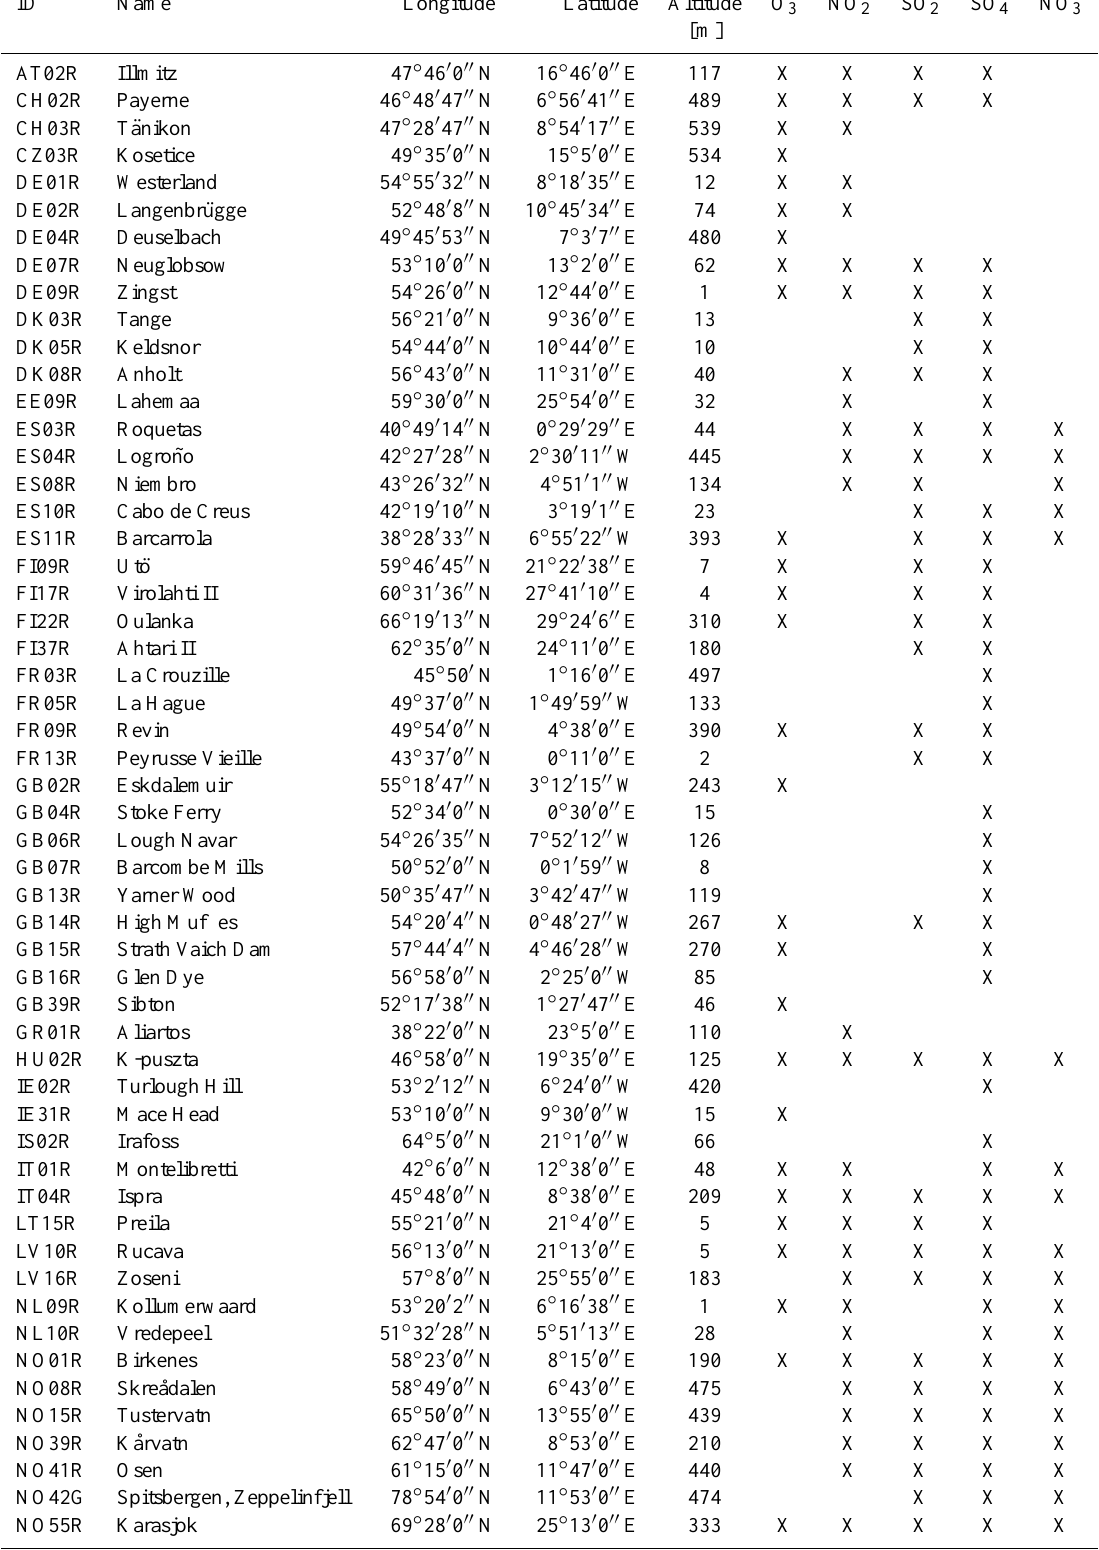
Table 4. EMEP measurement stations for the year 2000 used for comparison with modelled air concentrations. All station locations are depicted in Fig.